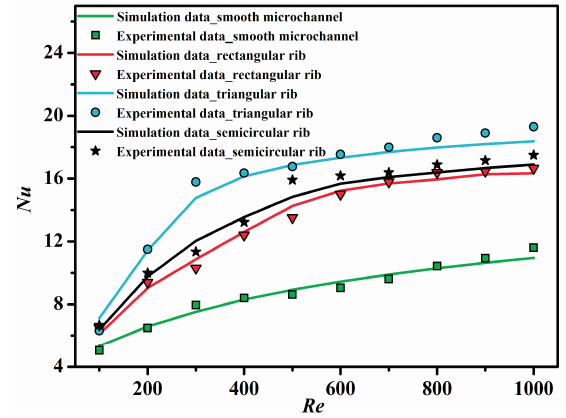
Figure 9. The Nusselt number as a function of the Reynolds number for all ribbed and smooth